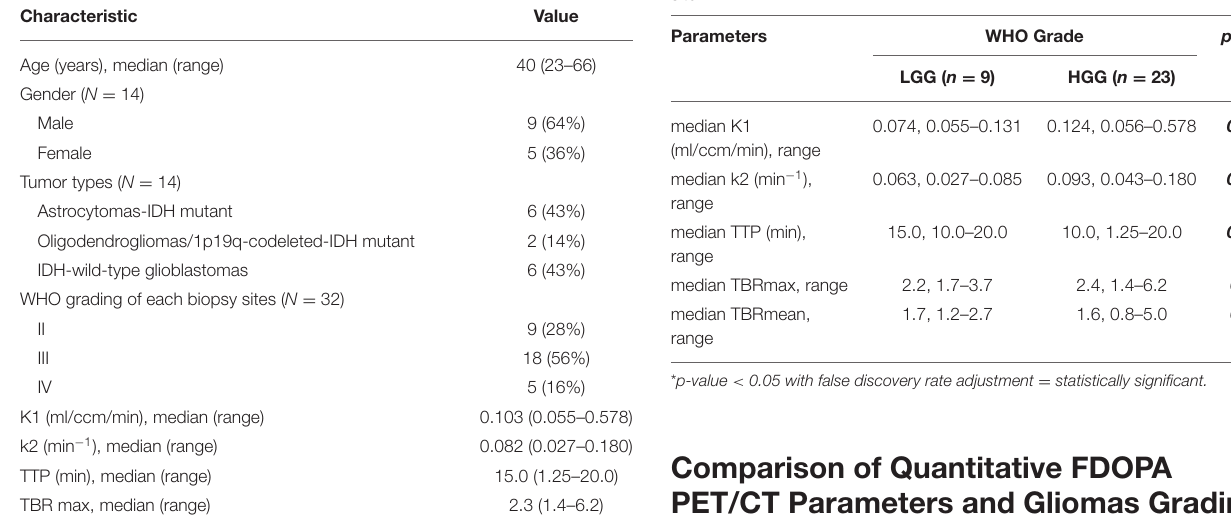
TABLE 1 | Summary of patient characteristics and imaging findings. TABLE 2 | Comparison of imaging parameters and WHO grade of each biopsy